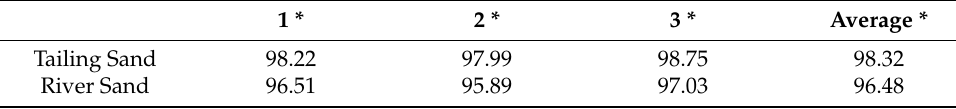
Table 2. The particle strength of two aggregate.